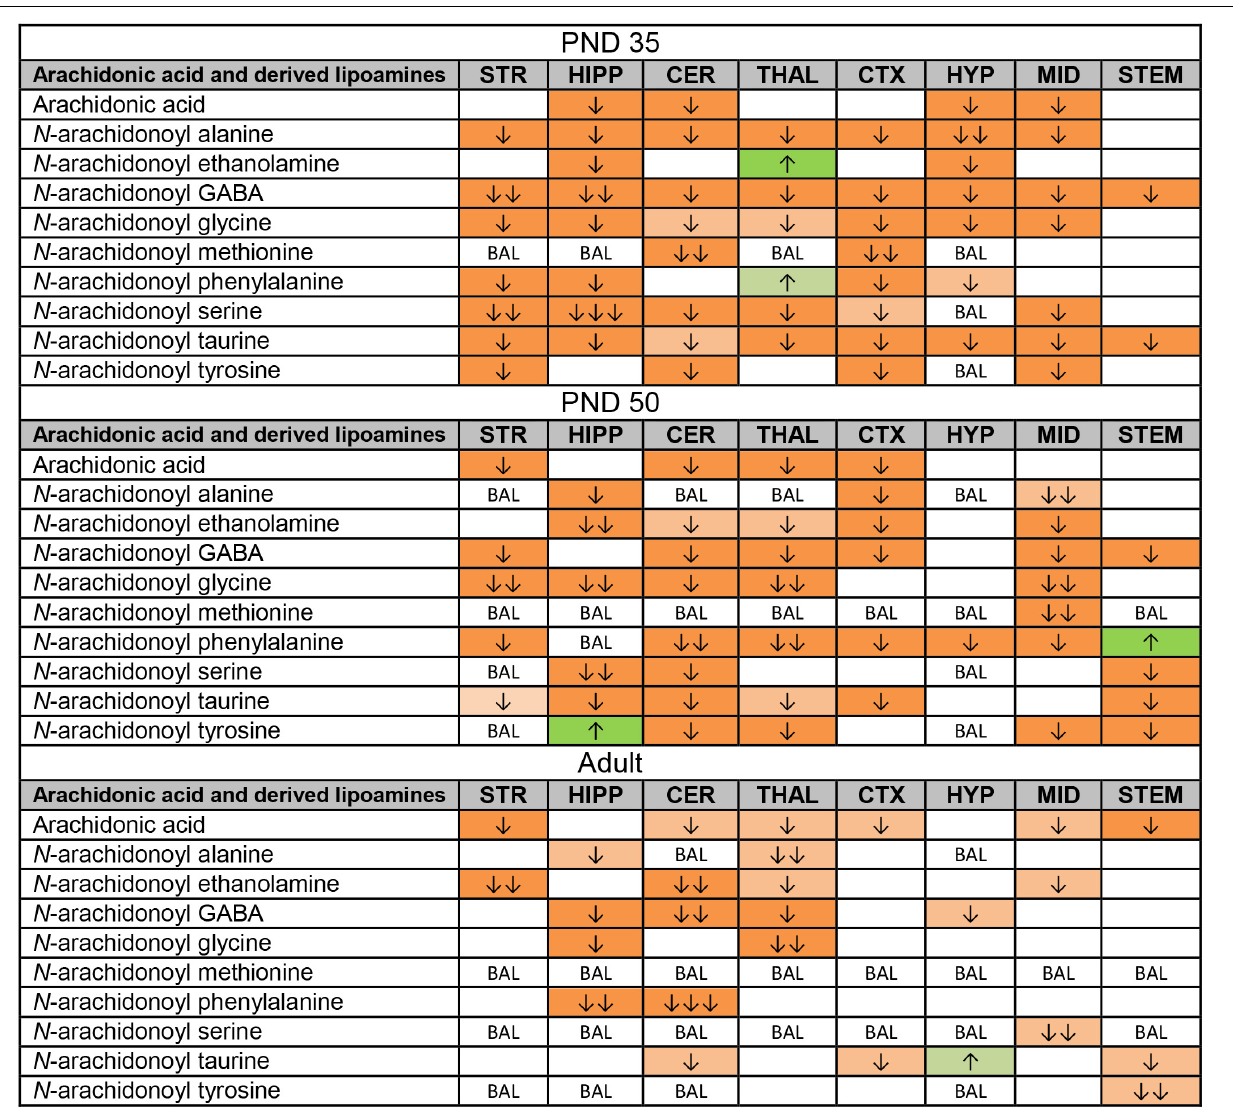
FIGURE 4 | Effects of acute CP 55,940 (CP) on levels of arachidonic acid and arachidonic acid-derived lipoamines in eight regions of the post-natal day (PND) 35, PND 50, and adult female mouse brain. Effects in the PND 35 brain are shown in the top portion, the PND 50 effects are shown in the middle portion, and the effects in the adult brain are shown in the bottom portion of the figure. Cells with shaded arrows indicate a change for that lipid in the CP-exposed brain area relative to the same vehicle-exposed area within each age group. The arrow color indicates the direction of a significant result relative to control. Green colors represent increases, with darker green representing a significant increase of p < 0.05 and lighter green representing a trending increase of p < 0.10. Orange colors represent decreases in a lipid’s concentration, with darker orange indicating a significant decrease of p < 0.05 and light orange representing a trending decrease of p < 0.10. The number of arrows indicates the magnitude of the difference between CP and vehicle. One arrow indicates a magnitude difference of less than 1.5-fold, two arrows indicates a 1.5- to 1.99-fold change, and three arrows indicate a 2- to 2.99-fold change. BAL stands for “Below Analytical Limit,” whereas a blank cell indicates that there was no change in the lipid’s level due to CP. See Supplementary Figure 4 for more detailed description of analysis. Abbreviations for brain areas are: STR, striatum; HIPP, hippocampus; CER, cerebellum; THAL, thalamus; CTX, cortex; HYP, hypothalamus; MID, midbrain; STEM,